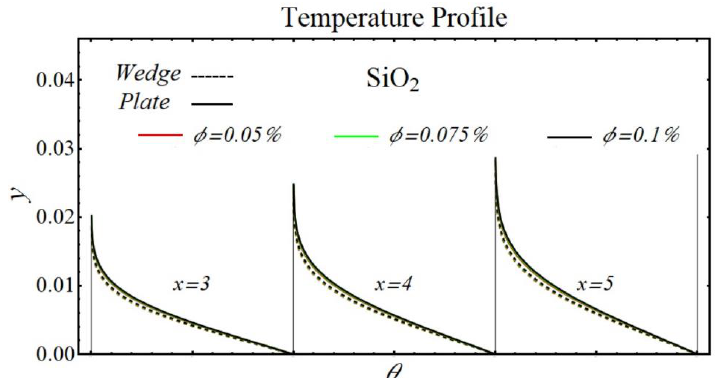
Figure 24. The temperature profile of SiO 2 /DIW nanofluids over the wedge and plate under the impact of nanoparticle volume fraction.